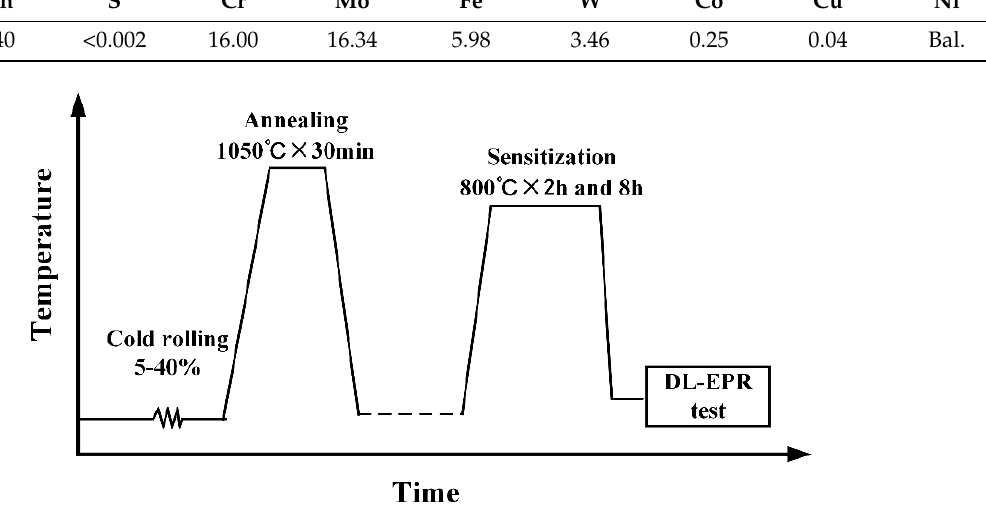
Figure 1. Schematic illustration of the processing, sensitization and IGC test.